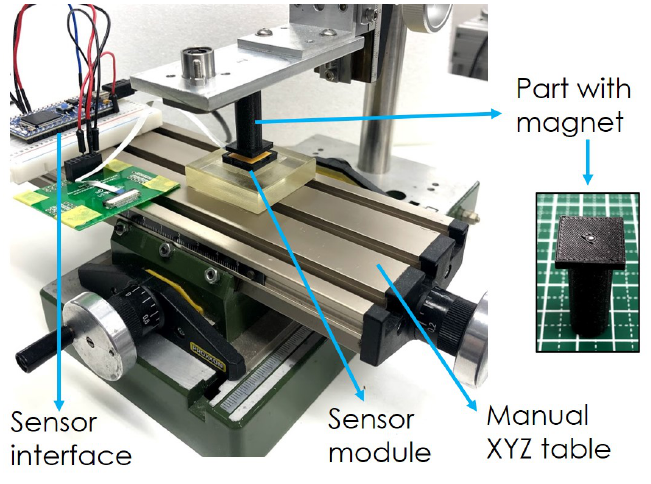
Figure 5. Magnetometer location experiment